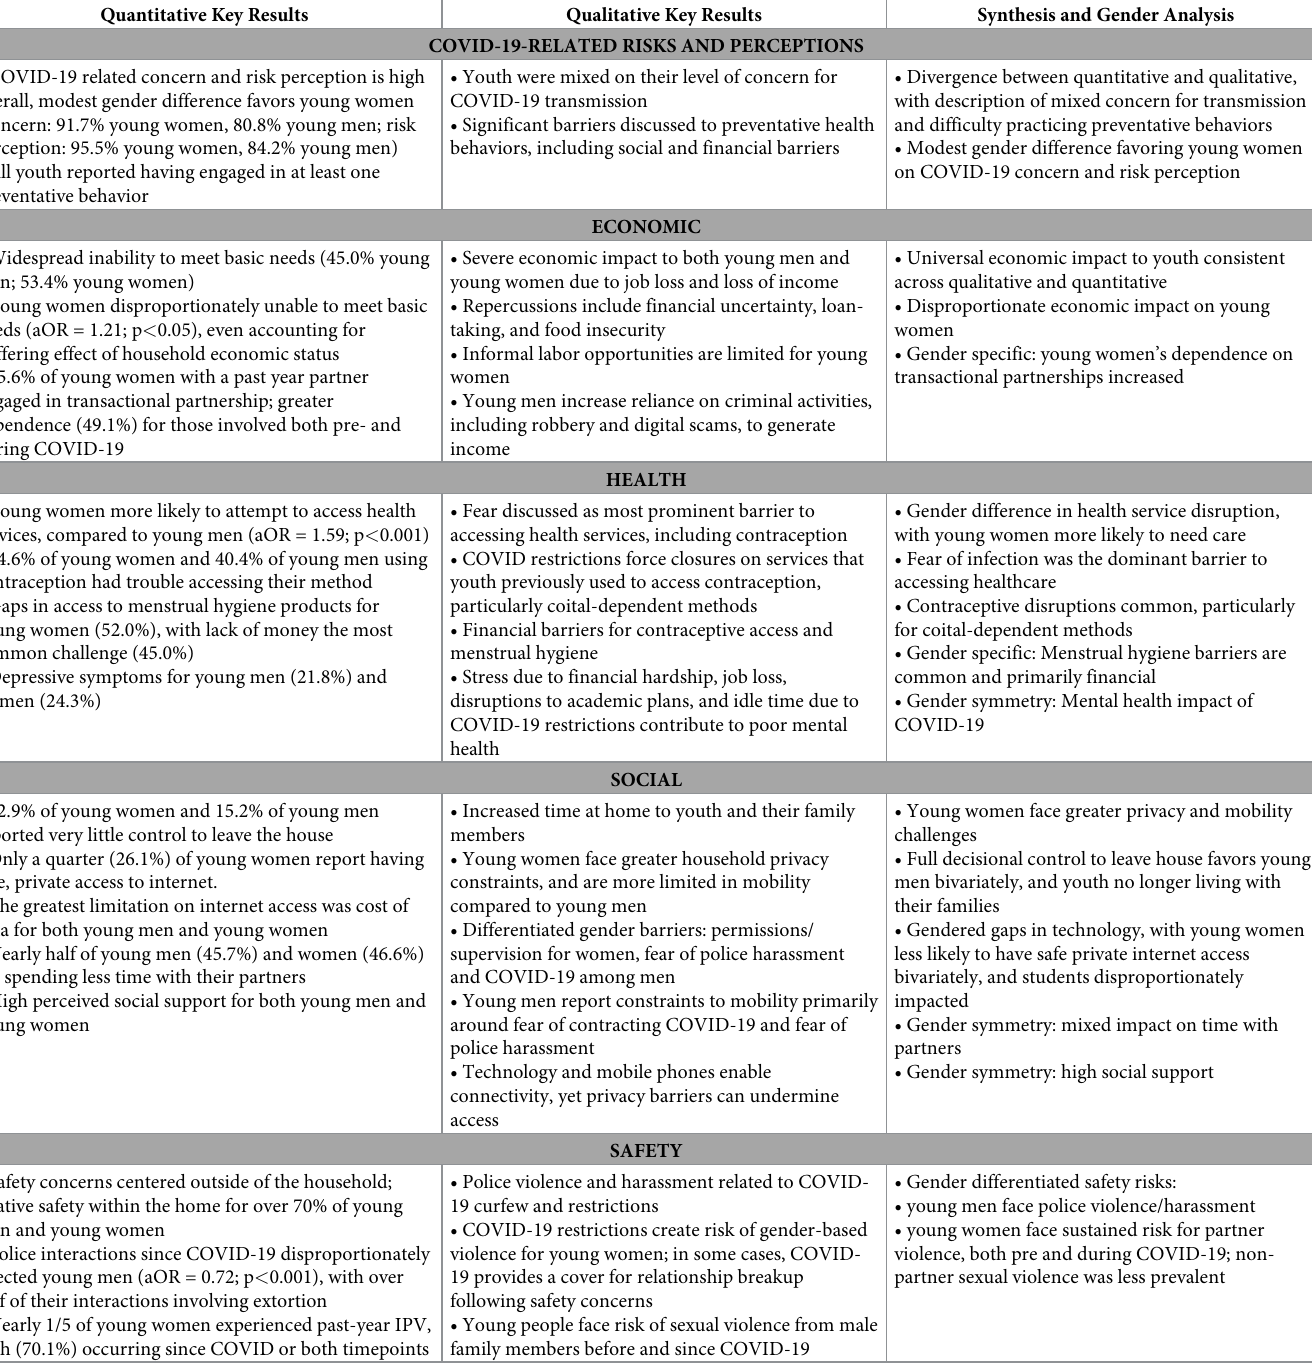
Table 4. Triangulation of quantitative and qualitative results, synthesis and gender